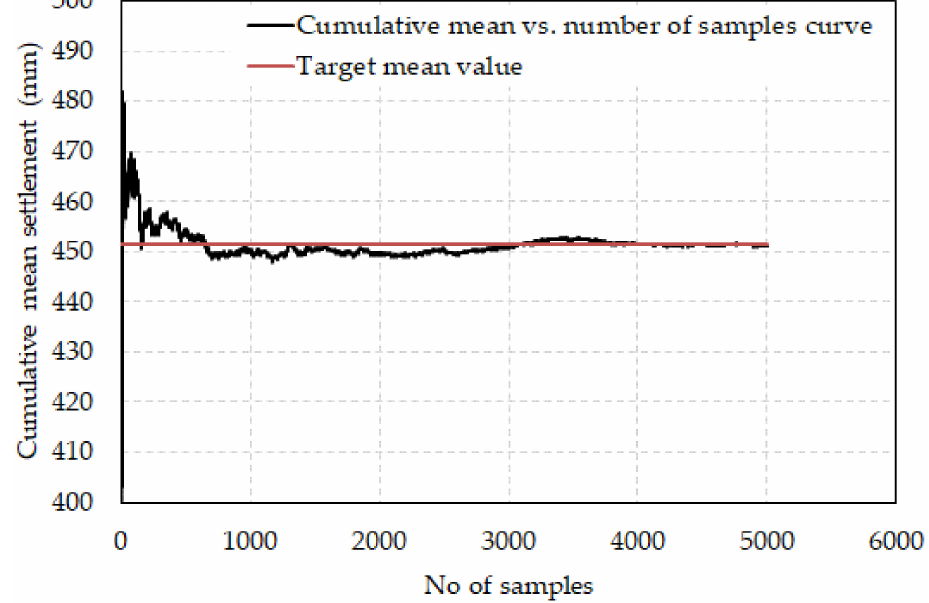
Figure 4. Generation of random samples and convergence of the number of samples (adopted from Class A prediction of the Karakore site—the settlement on 310th